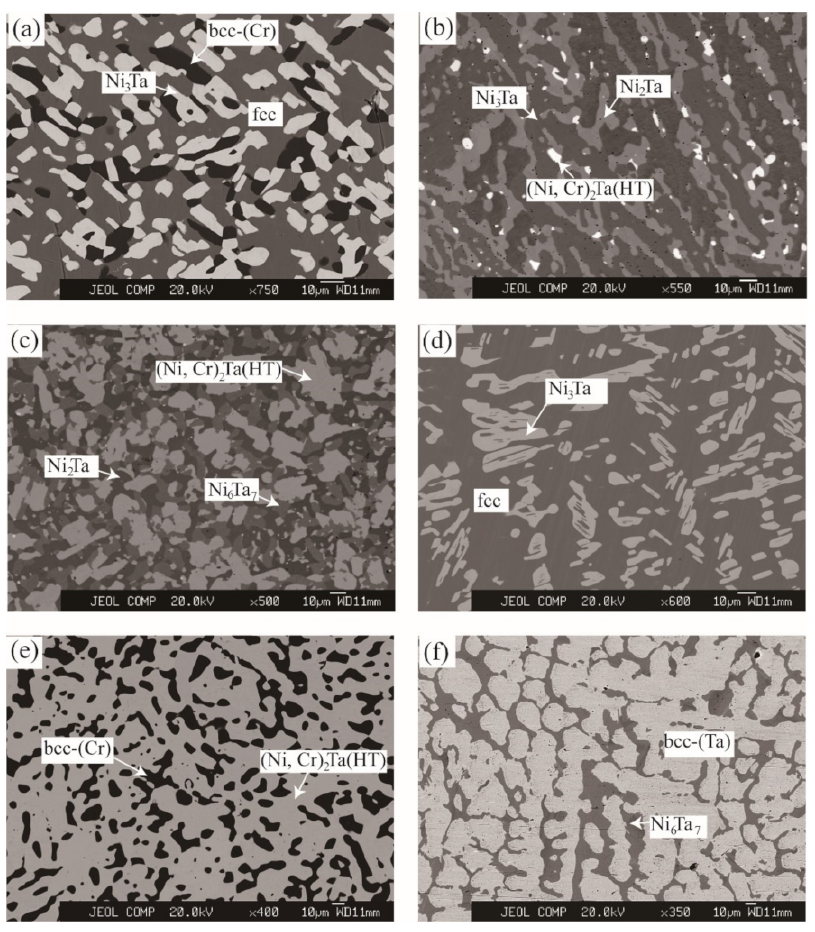
Figure 2. The microstructure of typical alloys in the Ni-Cr-Ta system annealed at 1200 ◦ C for 35 days. ( a ) Ni 53 Cr 37 Ta 10 ; ( b ) Ni 64 Cr 7 Ta 29 ; ( c ) Ni 53 Cr 8 Ta 39 ; ( d ) Ni 59 Cr 33 Ta 8 ; ( e ) Ni 27 Cr 53 Ta 20 ; ( f ) Ni 12 Cr 33 Ta 55 .